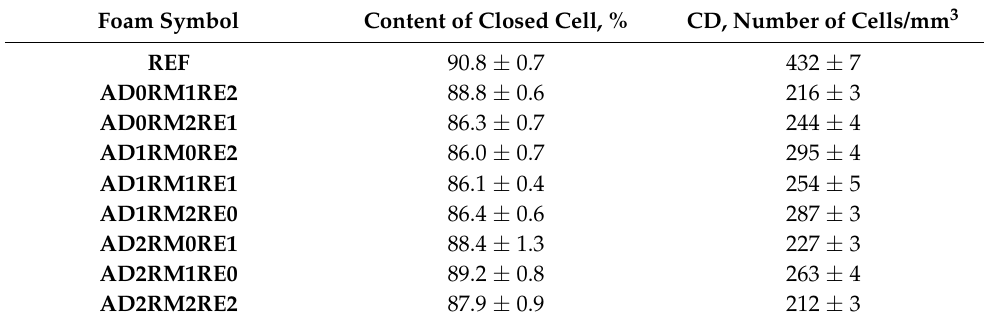
Table 3. Closed-cell content of the obtained polyurethane foams and average cell density.